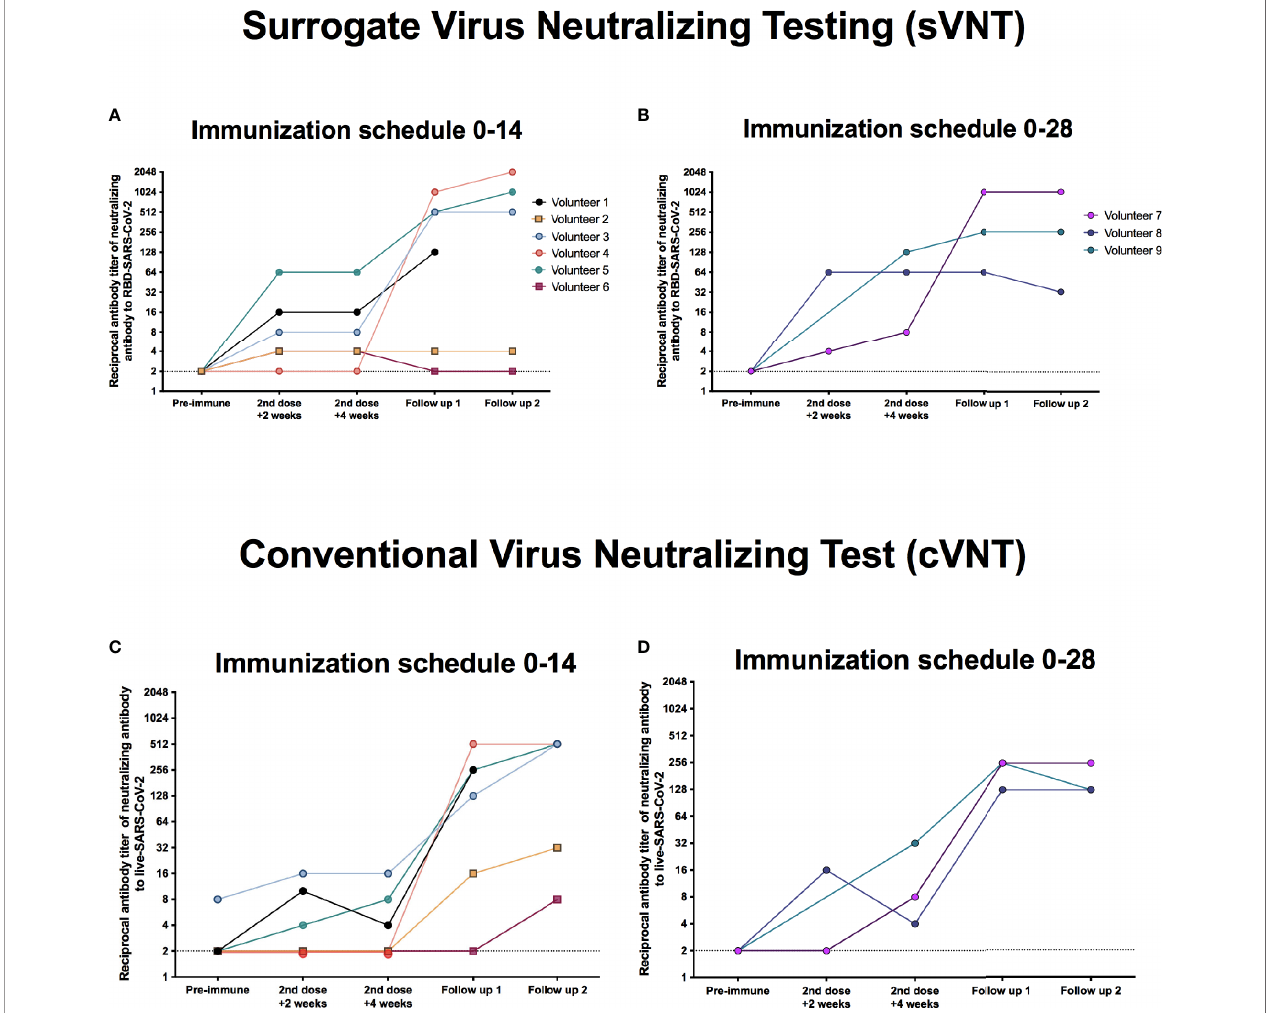
FIGURE 3 | Circulating antibodies exhibit varying neutralizing capacities in the nine breakthrough cases. Neutralizing antibodies were evaluated before administration of the fi rst dose (pre-immune), 2 and 4 weeks after the second dose, and 2 and 4 weeks after the disease onset (follow-up 1 and 2, respectively). Two different techniques were used, a surrogate virus neutralization test (sVNT) based on the perturbation of the hACE2-spike protein – protein interaction mediated by antibodies, and a conventional virus neutralization test (cVNT) evaluating plaque and CPE reduction. (A) Neutralizing antibody titers detected by using the sVNT in six volunteers enrolled in the 0 – 14 immunization schedule. (B) Neutralizing antibody titers detected by using the sVNT in three volunteers enrolled in the 0 – 28 immunization schedule. (C) Neutralizing antibody titers detected by using the cVNT in six volunteers enrolled in the 0 – 14 immunization schedule. (D) Neutralizing antibody titers detected by using the cVNT in three volunteers enrolled in the 0 – 28 immunization